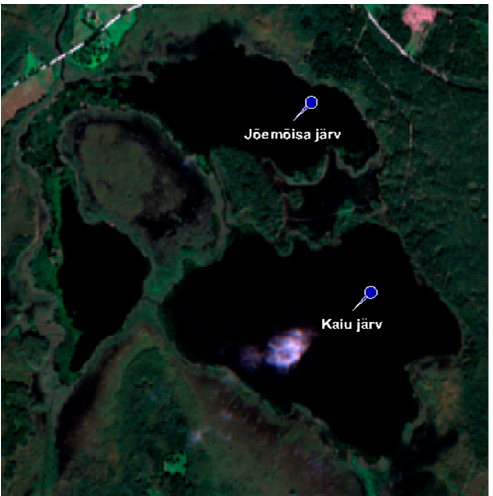
Figure A1. S2 MSI image of Jõemõisa and Kaiu from 28th of August 2016.